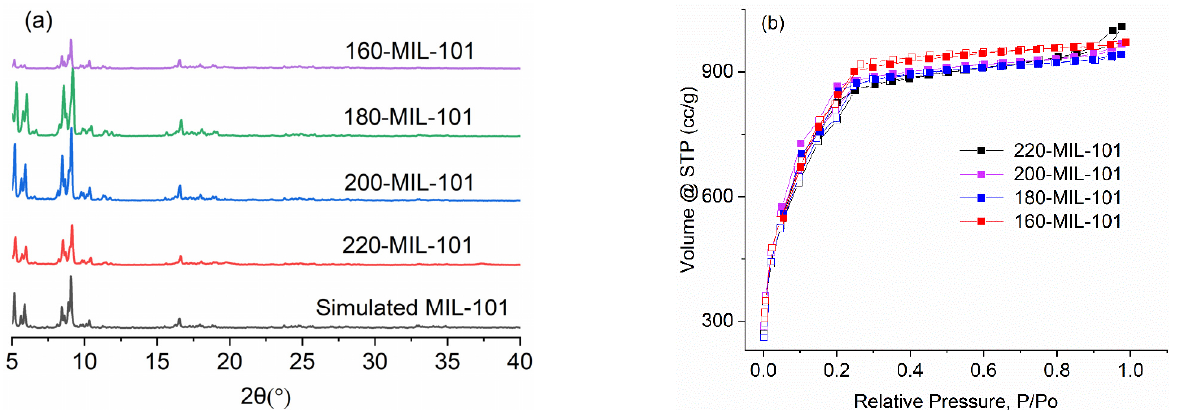
Figure 2. ( a ) XRD patterns of the samples, ( b ) the N 2 adsorption–desorption isotherms of the samples. Table 1. Yield, particle size, surface area, and pore volume of